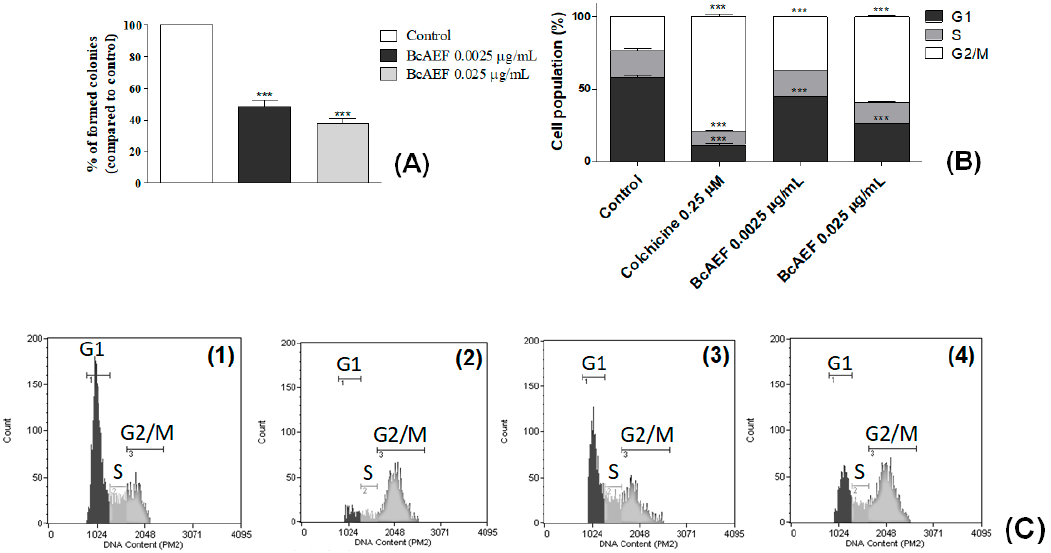
Figure 2. Inhibitory effects of BcAEF on NCI-H460 cell proliferation and cell cycle. ( A ) Percentage of colonies in the colony formation assay of untreated cells (control) and cells treated with 0.0025 and 0.025 µg mL − 1 of BcAEF. ( B ) Influence on NCI-H460 cell cycle. NCI-H460 cells were treated for 30 h with 0.25 µM of colchicine (positive control), 0.0025 and 0.025 µg mL − 1 of BcAEF. Statistical analysis: two-way ANOVA followed by Bonferroni test (*** p < 0.001, relative to untreated cells-control). ( C ) Histograms of cell cycle analysis (cell count vs. DNA content, Guava Cell Cycle module) of ( 1 ) untreated cells—control, ( 2 ) 0.25 µM of colchicine, ( 3 ) 0.0025 µg mL − 1 and ( 4 ) 0.025 µg mL − 1 of BcAEF over NCI-H460 cells (30 h), showing cell population in G1, S and G2/M phases.